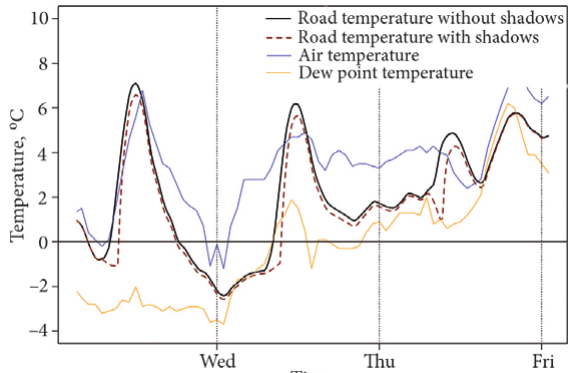
Fig. 10. Comparison of METRo forecasts with and without shades